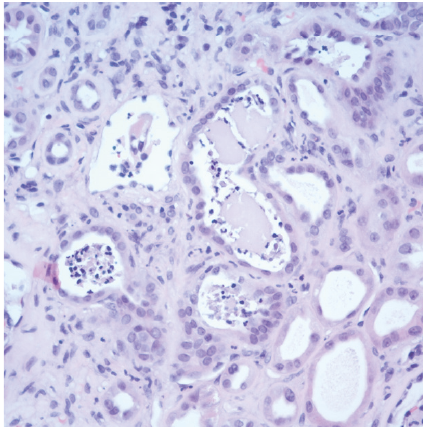
Figure 2: Many tubules are dilated with flattening of epithelium. In the adjacent tubules, multiple neutrophilic casts are